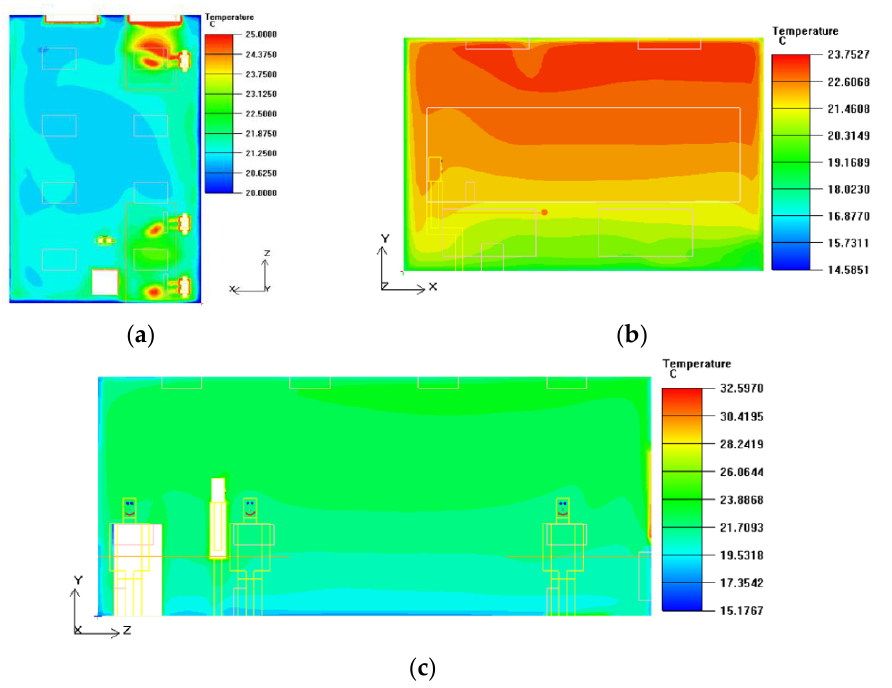
Figure 11. Air temperature distribution at 2:30 pm on March 14th: ( a ) Y = 0.6 m; ( b ) Z = 3.45 m; ( c ) X = 2.3 m.